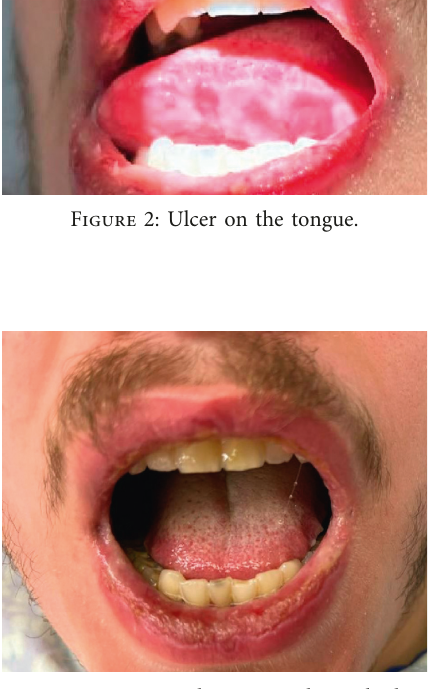
Figure 3: Mucocutaneous lesions involving the lower lip.